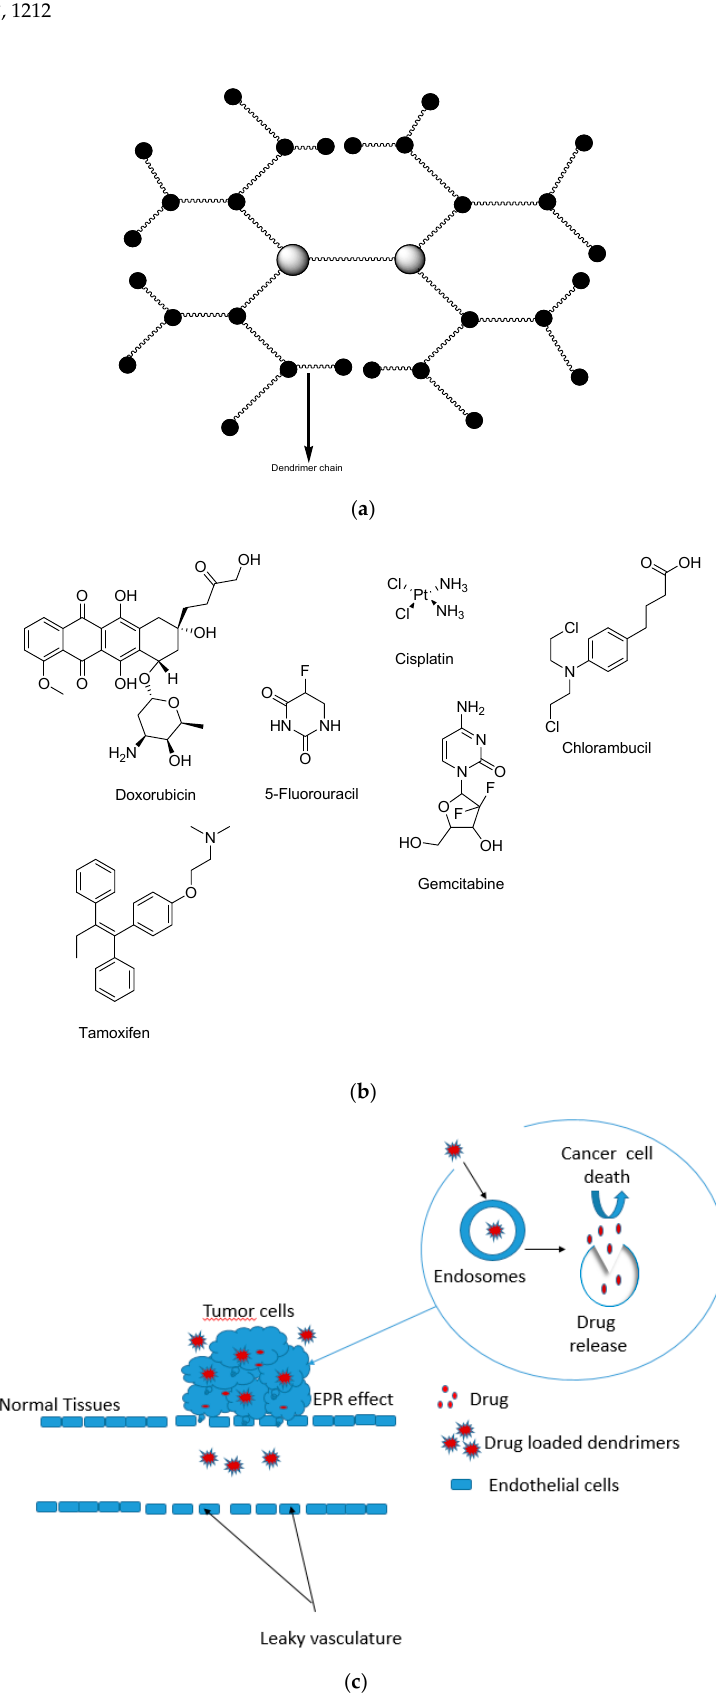
Figure 2. ( a ): A schematic diagram of a dendrimer. ( b ): Structures of some anticancer drugs which have been loaded into dendrimers. ( c ): Drug uptake from dendrimer into tumor cells via EPR effect. The other advantages of dendrimers in chemotherapy include enhanced drug efficacy, improved drug biocompatibility, reduced drug toxicity, and controlled and sustained drug release kinetics [69–72].